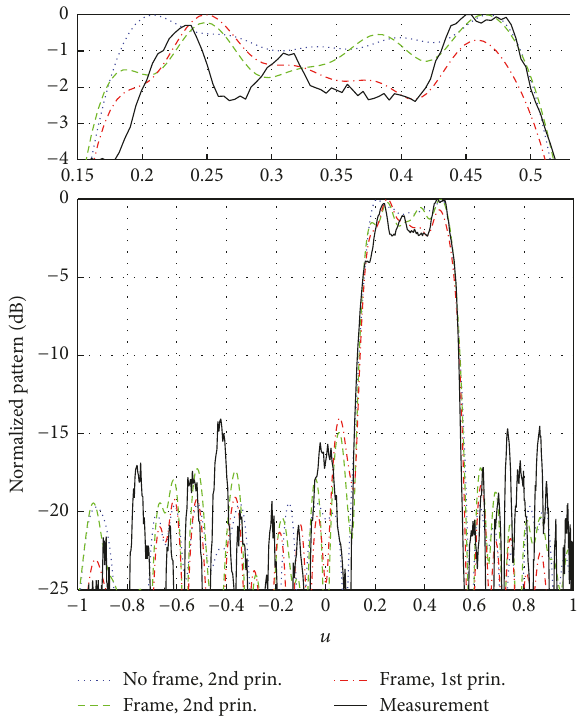
Figure 11: Comparison of the measurements and simulations in the main cut for V = 0